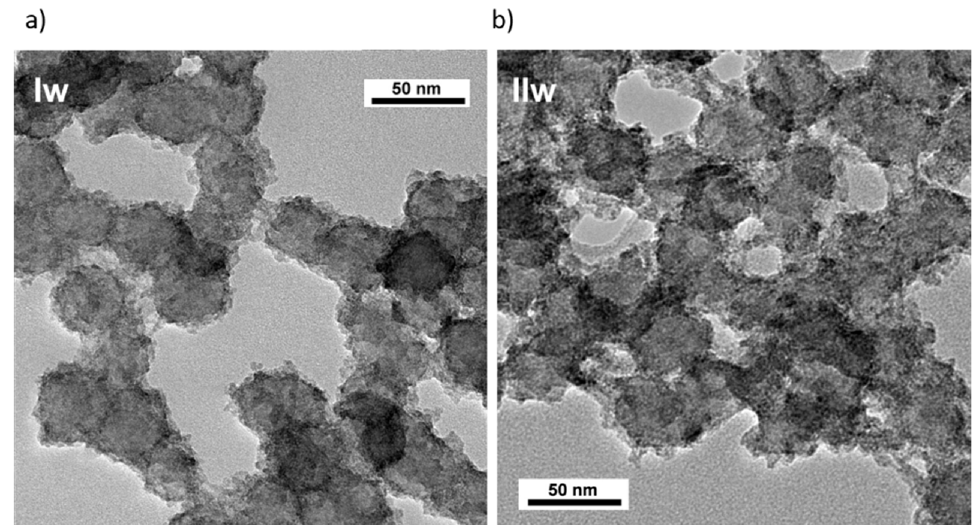
Figure 2. TEM pictures of SZ3 (50 nm diameter) NPs after dialysis into water at different age: ( a ) Iw at 1. day) and ( b ) IIw at 7. days. Both samples presented rough NP surface, showing a structural change of zirconia when transferred from ethanol to